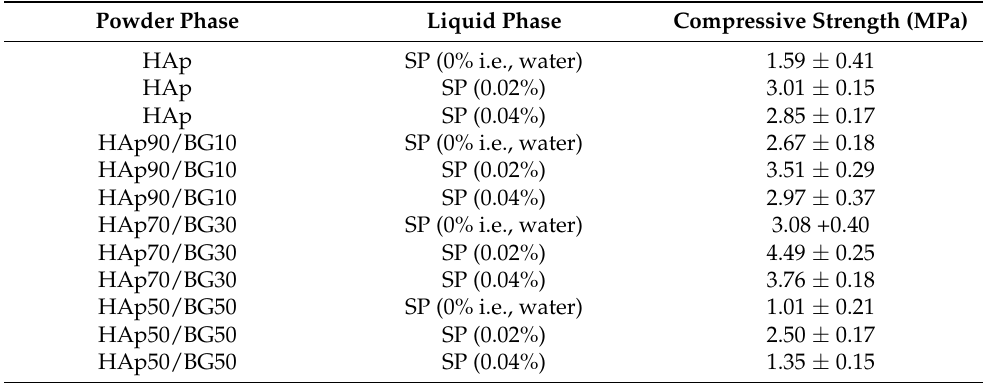
Table 5. Effects of liquid phase concentration on compressive strength (the results were expressed as mean ± SD, n = 3).